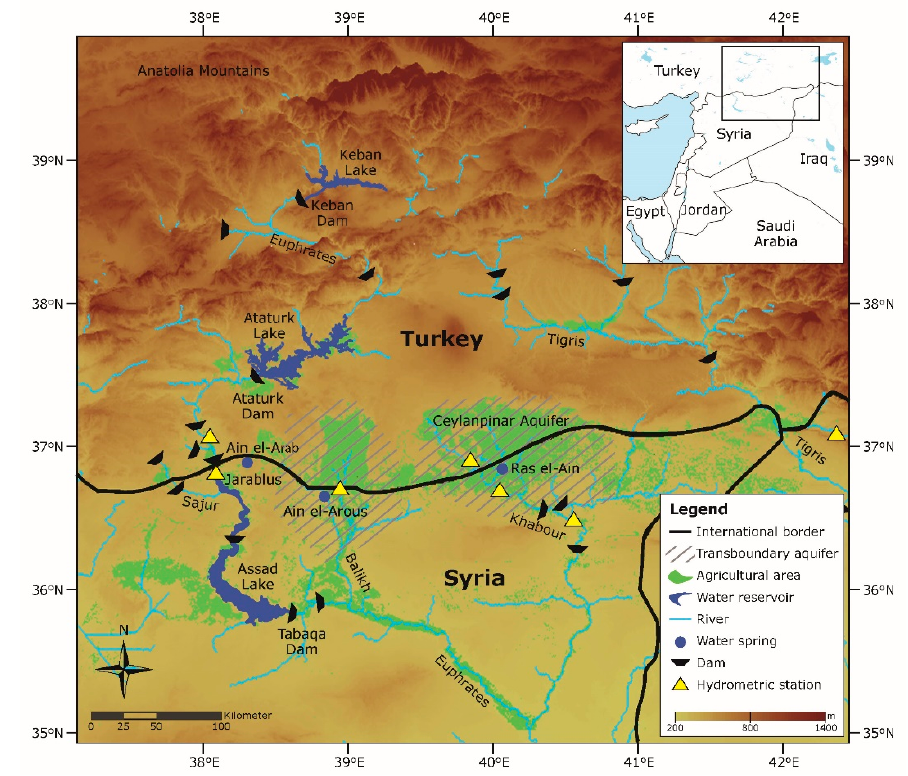
Figure 1. The Euphrates River Basin with its water structures, including the main dams, water reservoirs, and hydrometric stations (based on data from [9]).